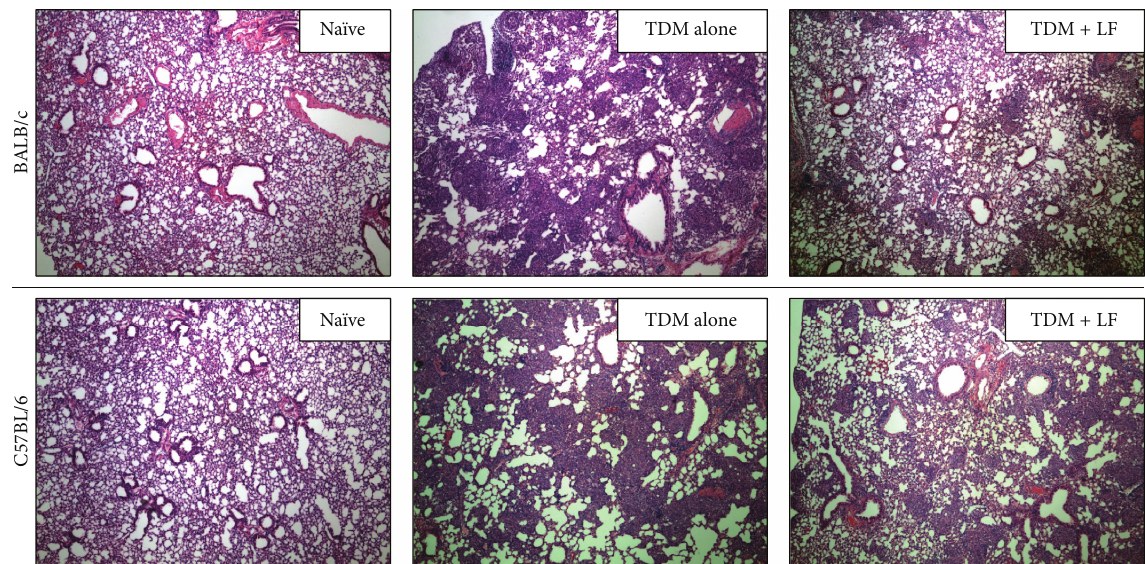
Figure 4: Granuloma response to TDM challenge in oral recombinant human lactoferrin-treated mice. Two strains of mice (BALB/c and C57BL/6) were challenged with 25 𝜇 g TDM in a water-in-oil emulsion, as described [38, 101]. Human lactoferrin (recombinant, 1mg) was given orally at 4 and 6 days after TDM challenge. Comparisons are made to na¨ıve mice, and to mice only administered TDM. H&E staining, 100x. Representative sections from mice at 7 days after TDM challenge; 𝑁 ≥ 8 per experimental